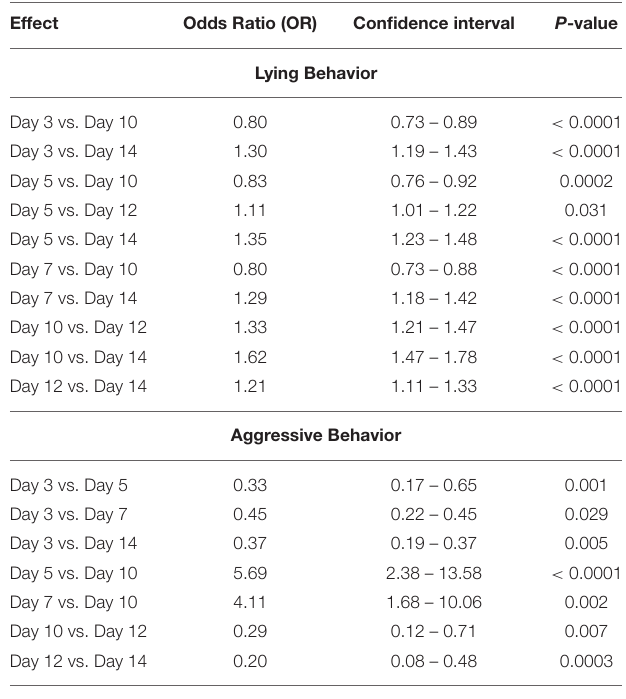
TABLE 5 | Significant odds ratios (OR) of pigs performing lying and aggressive behavior (based on the ethogram) by sample day of study